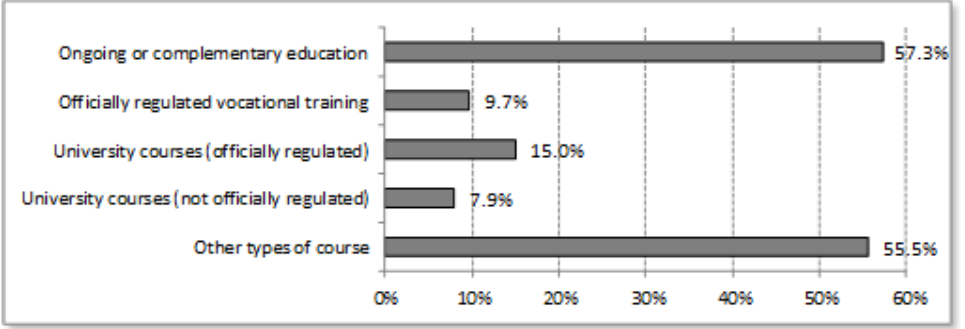
Figure 5. Type of courses in which deaf and hard of hearing individuals have participated at some time (relative data). Multiple answers possible. Valid answers: 227.